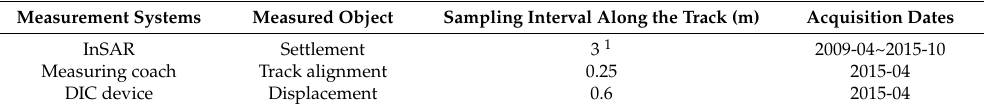
Table 2. Key parameters of the InSAR, the measuring coach and the DIC